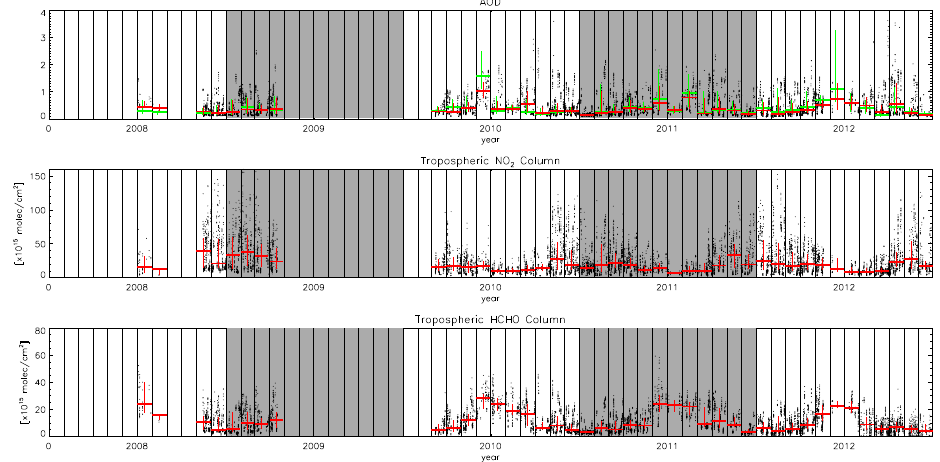
Figure 9. Time series of individual data points and monthly medians of AOD (Vis), and tropospheric column densities of NO 2 and HCHO, obtained with method A. The black dots refer to individual profiles and the red lines refer to monthly medians. AOD from AERONET is shown in green (upper row). In 2008/2009 the instrument was installed in Beijing; from 2010 onwards it was stationed in